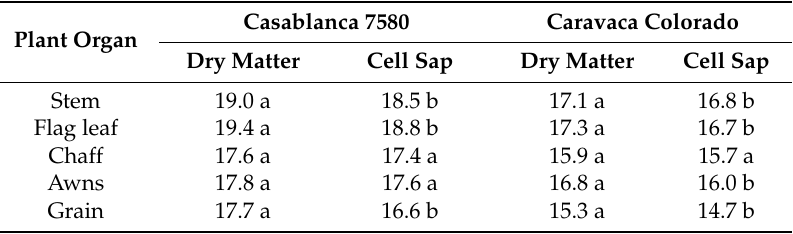
Figure 2. Grain carbon isotope discrimination values of the different treatments carried out on two durum wheat genotypes grown under field conditions during two consecutive growth seasons. Table 4. Carbon isotope discrimination of dry matter and cell sap determined on different plant of the cultivars Casablanca 7580 and Caravaca Colorado in Season 2. For each genotype, means followed by a different letter are significantly different by Duncan’s multiple range test at p < 0.05. LSD: least significant